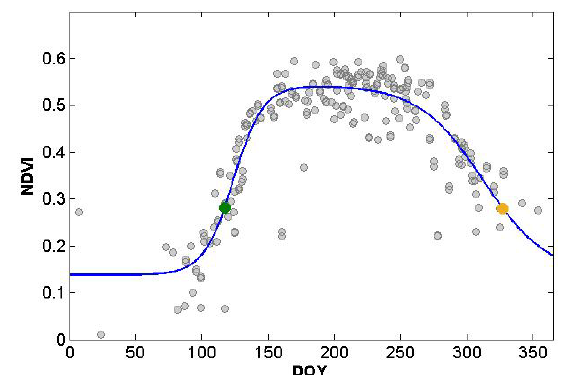
Figure 2. The identification of LSP transaction dates from Landsat NDVI value using double logistic regression model (green dot is SOS, yellow dot is